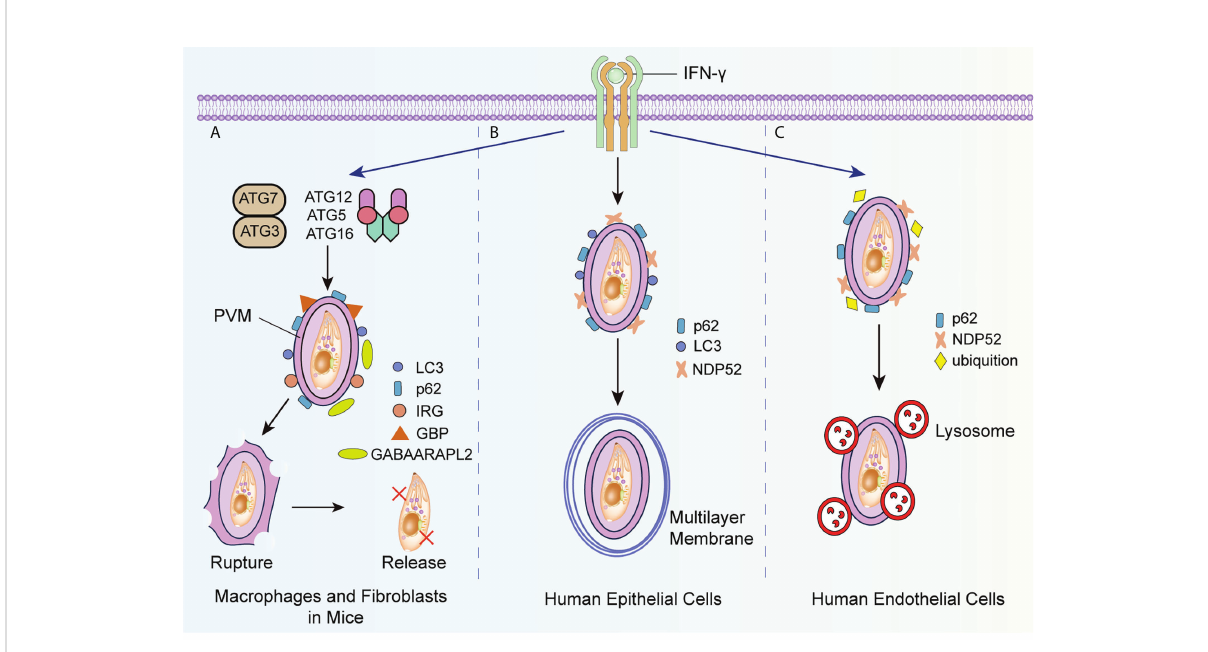
FIGURE 2 IFN- g induced autophagic killing to T. gondii in different host cells. (A) IFN- g promotes the recruitment of ATG3, ATG7 and ATG5-ATG12- ATG16L1 complex-dependent LC3, ATG8 homologs and ubiquitinated p62 to the PVM, and that of GBP and IRG to the PMV surface with the assistance of ATG8 homologs such as GABAARAPL2, causing the collapse of the PVM bubble and the release of T. gondii into the cytoplasm. (B) When type II and III T. gondii strains infect epithelial cells, IFN- g recruits LC3, ubiquitinated p62, and ubiquitinated NDP52 to the PVM, and generates the multilayer membrane structure around the PVM to suppress the growth of T. gondii . (C) In human endothelial cells infected with T. gondii , IFN- g promotes the recruitment of ubiquitinated p62 and NDP52 to the PVM and indues the fusion of lysosome with PV. GABAARAPL2, gamma-aminobutyric-A receptor-associated protein like